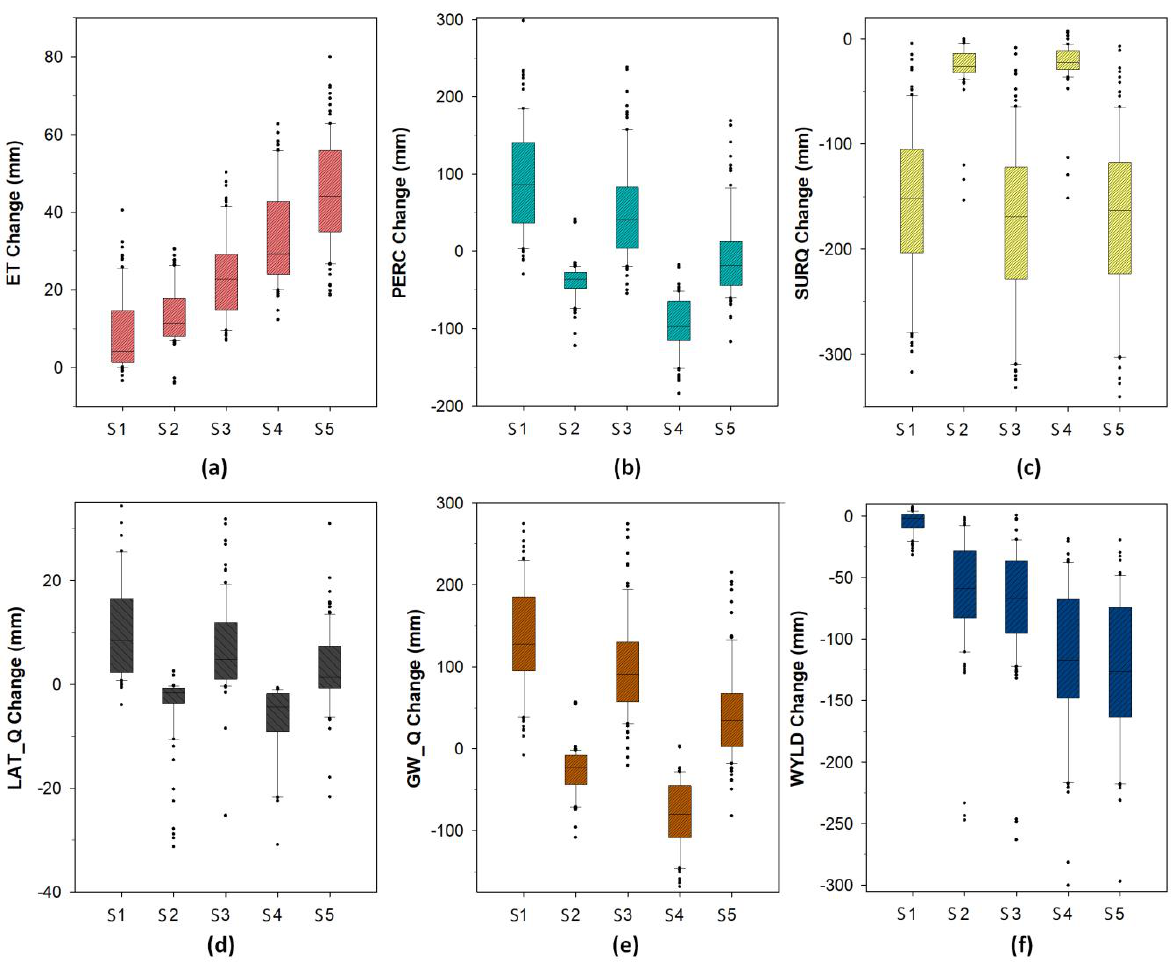
Figure 7. Individual and combined effects of land use/cover change and climate change at Muco watershed on the ET ( a ), PERC ( b ), SURQ ( c ), LAT_Q ( d ), GW_Q ( e ) and WYLD ( f ). (Horizontal scale: S1: LU2051_Historical; S2: LU2011_ Immediate Future; S3: LU2051_ Immediate Future; S4: LU2011_ Intermediate Future; S5: LU2051_ Intermediate Future).